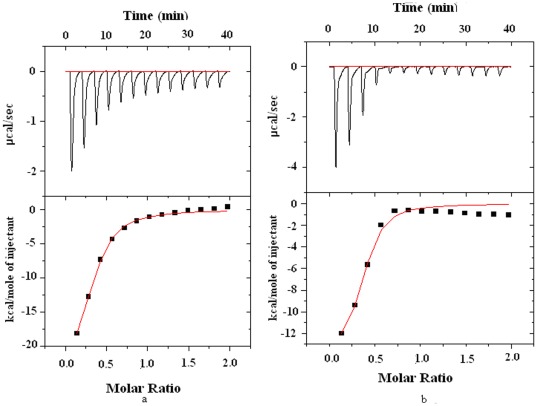
ITC data for the titration of (a) the N and (b) the B forms of HSA with virstatin.Flow of heat with time during the injection of the drug and the heat evolved per mole of added drug for each injection, shown at the top and the bottom, respectively.